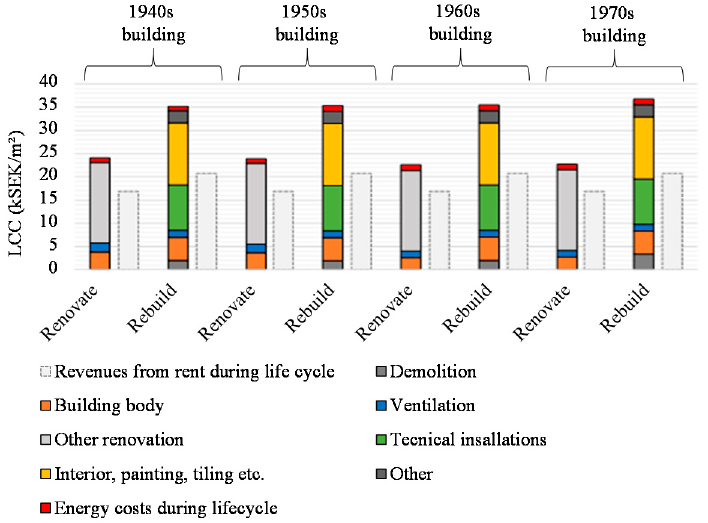
Figure 10. LCC for renovation and demolition and construction, as well as the revenues from rent during the building life cycle.